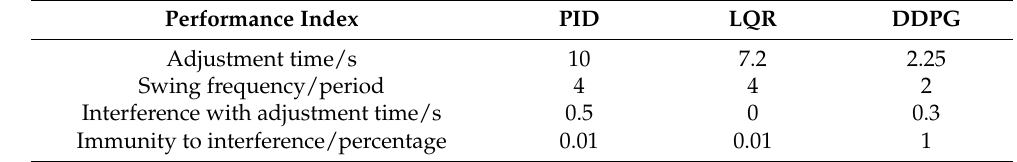
Table 2. The key indicators of three algorithms in the self ‐ recovery process.